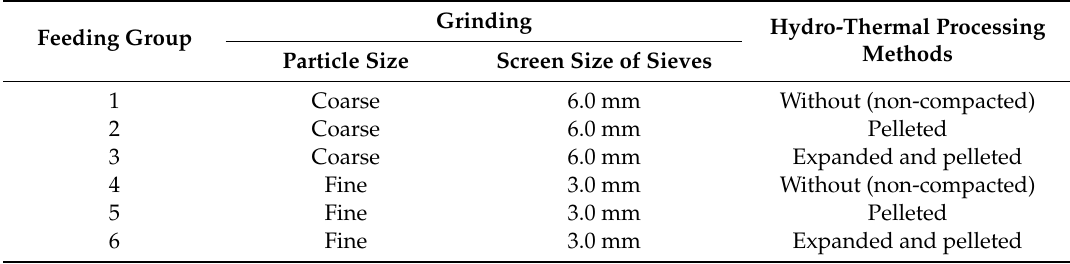
Table 3. Experimental design: Combination of technical feed